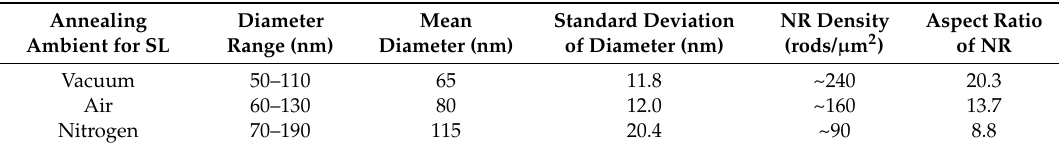
Figure 2. Field emission scanning electron microscopy (FE-SEM) (top view) of the ZnO NRs grown on SLs annealed in ( a ) vacuum; ( b ) air; and ( c ) nitrogen. Cross-sectional views of the ZnO NRs are shown in ( d ). Histogram for the diameter distribution of NRs grown on SLs annealed in ( e ) vacuum; ( f ) air, and ( g ) nitrogen. Table 1. Morphologies of the ZnO NRs (measured by FE-SEM) prepared under three different SL annealing ambient conditions.